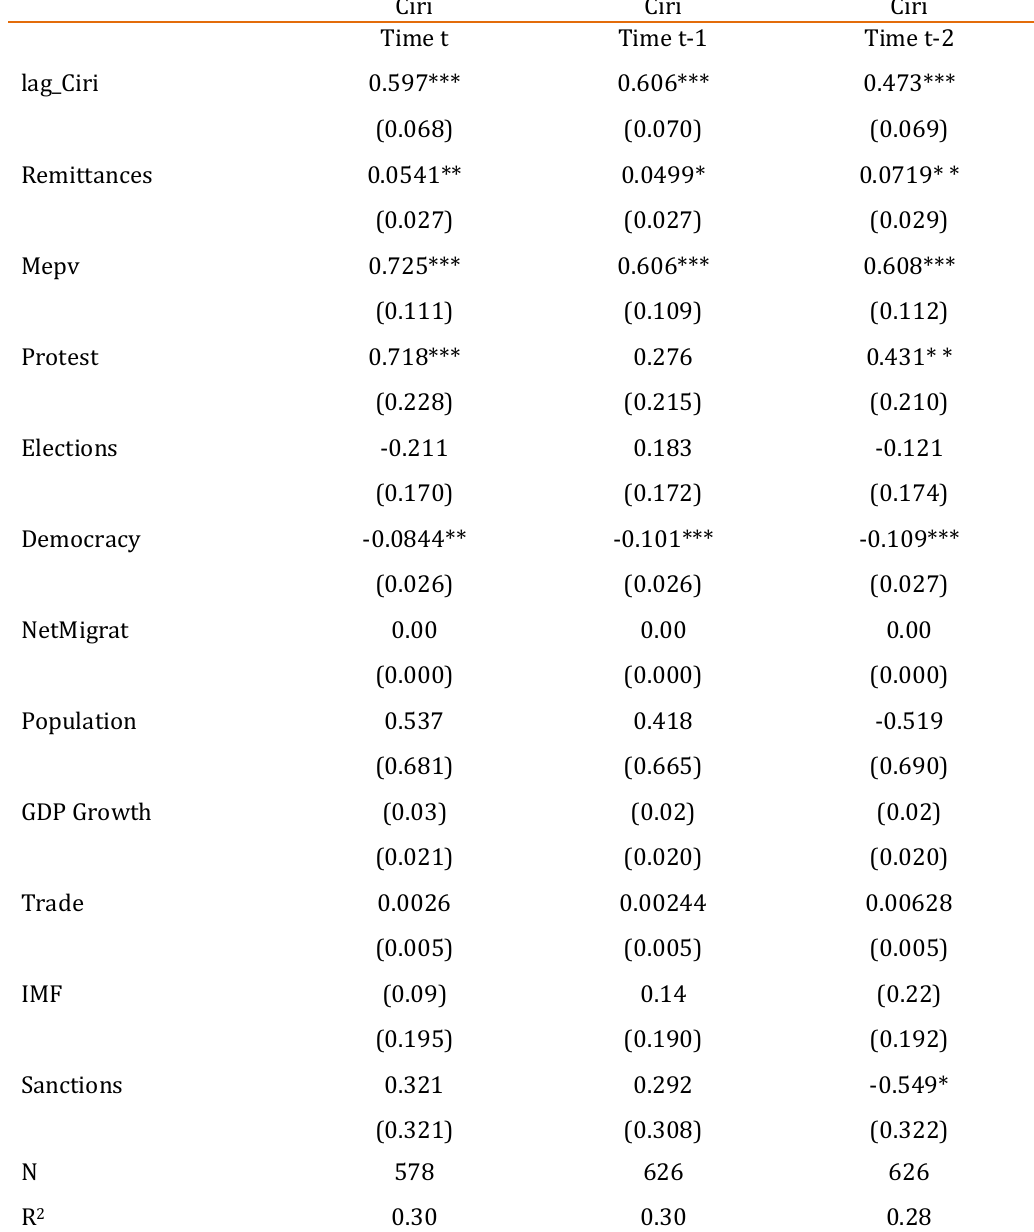
Table 02. Effect of remittances on the level of violations of rights to physical integrity (1981 –